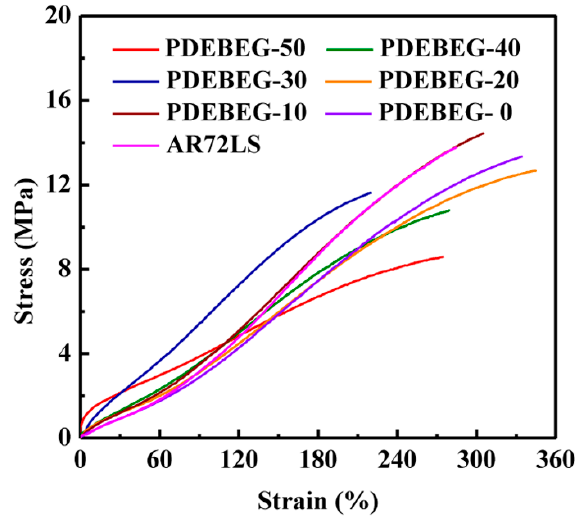
Figure 9. Stress–strain curves of the PDEBEG / CB and AR72LS / CB nanocomposites.